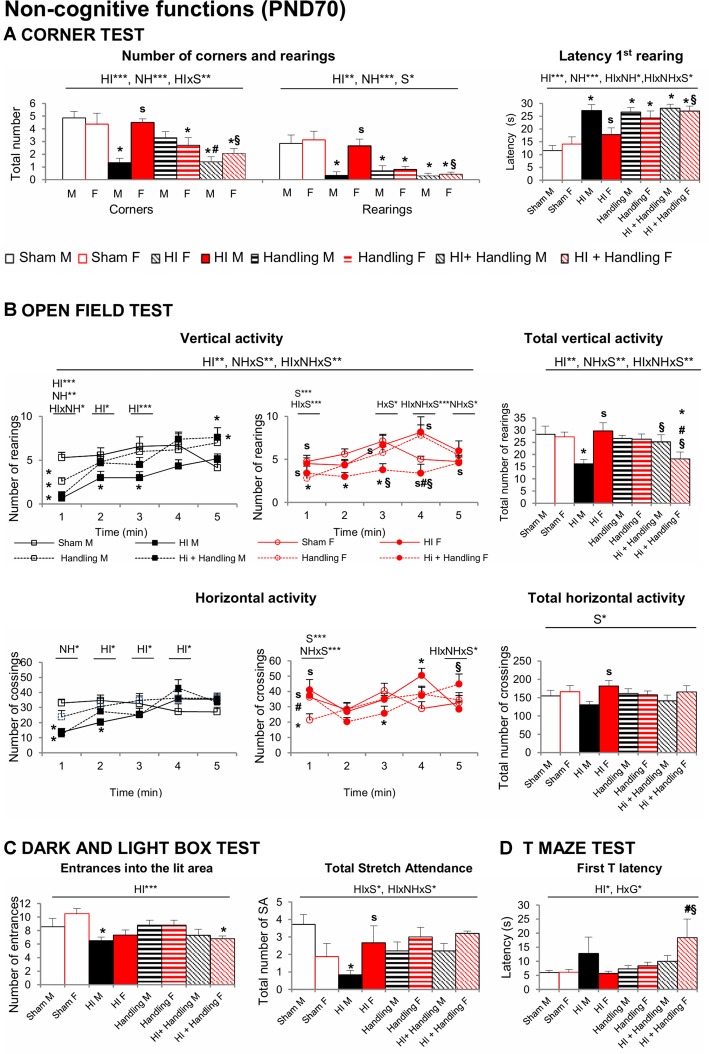
Corner test (CT). OF. DLB. TM: short- and long-effects of HI in males and females C57BL6 and effects of NH. Non-cognitive functions were evaluated during PND70–PND90. Results are presented as mean ± SEM. (A) The neophobia in the CT was increased in hypoxia males and in both handling and HI + NH males and females. HI induced anxiety-like behavior in the OF (B) that lead to reduced exploratory activity with males being mostly affected. The anxious profile could be also observed in several variables measured by DL (C) were HI males and HI + NH females performed fewer entrances into the lit area. Moreover, HI males presented also fewer number of stretch attendance. Finally, in the TM (D) the highest values in the first T-latency were spent by HI + NH female, although there’s no significant difference, HI male also spent more time to reach the intersection. Statistics: RMA, two-way ANOVA: “HI” Hypoxia effect; “NH” handling effect; “S” sex effect; “A” age effect *P < 0.05, **P < 0.01, and ***P < 0.001, followed by Duncan’s post hoc test. *P < 0.05 vs. sham of the same sex; #P < 0.05 vs. handling of the same sex; §P < 0.05 vs. hypoxia of the same sex; sP < 0.05 female vs. male of the same treatment.